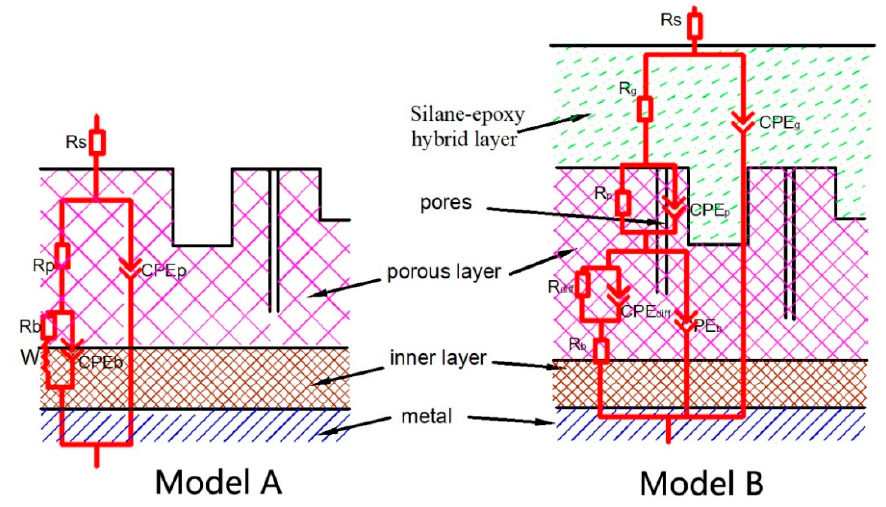
Figure 7. Proposed equivalent circuits.